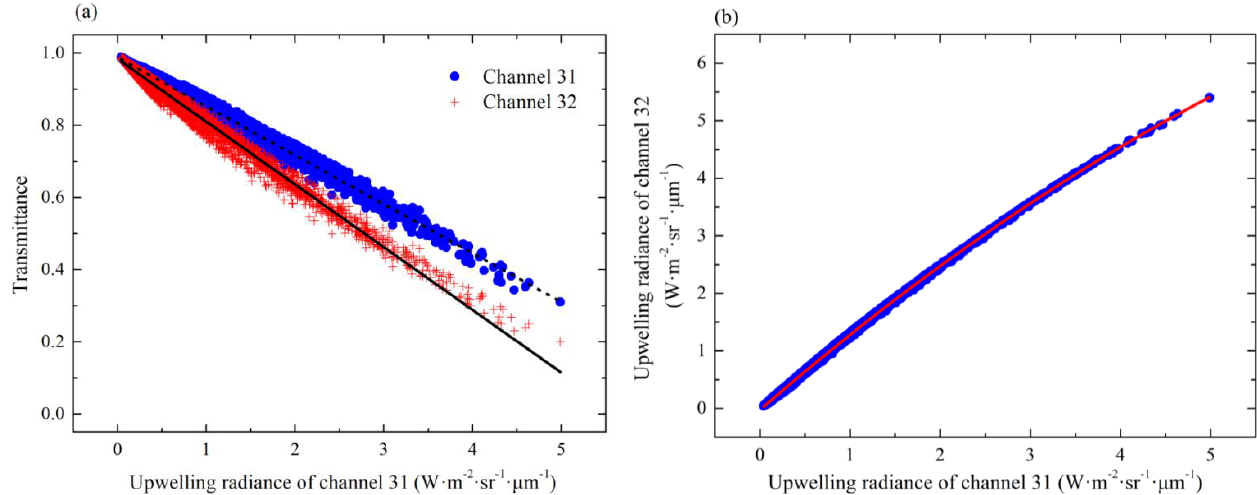
Figure 2. Scatter plots between the atmospheric upwelling radiance of MODIS channel 31 and the other atmospheric parameters. ( a ) transmittances of channels 31 and 32; ( b ) upwelling radiance of channel